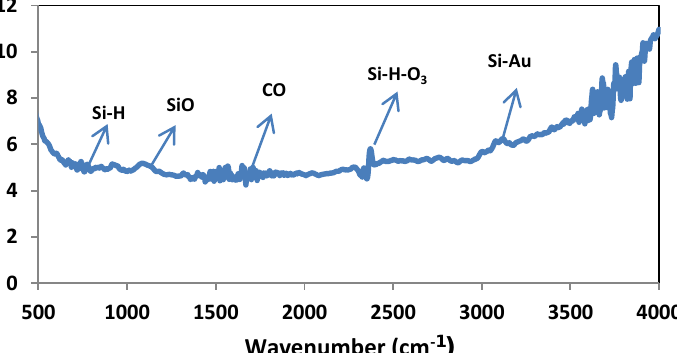
Fig.10: XRD of AuNPs/PS/c-Si /Al.